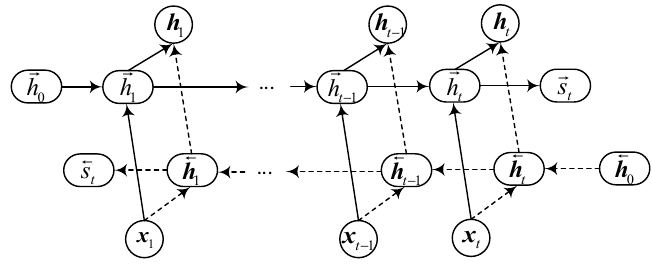
Figure 2. The network structure of BiGRU.